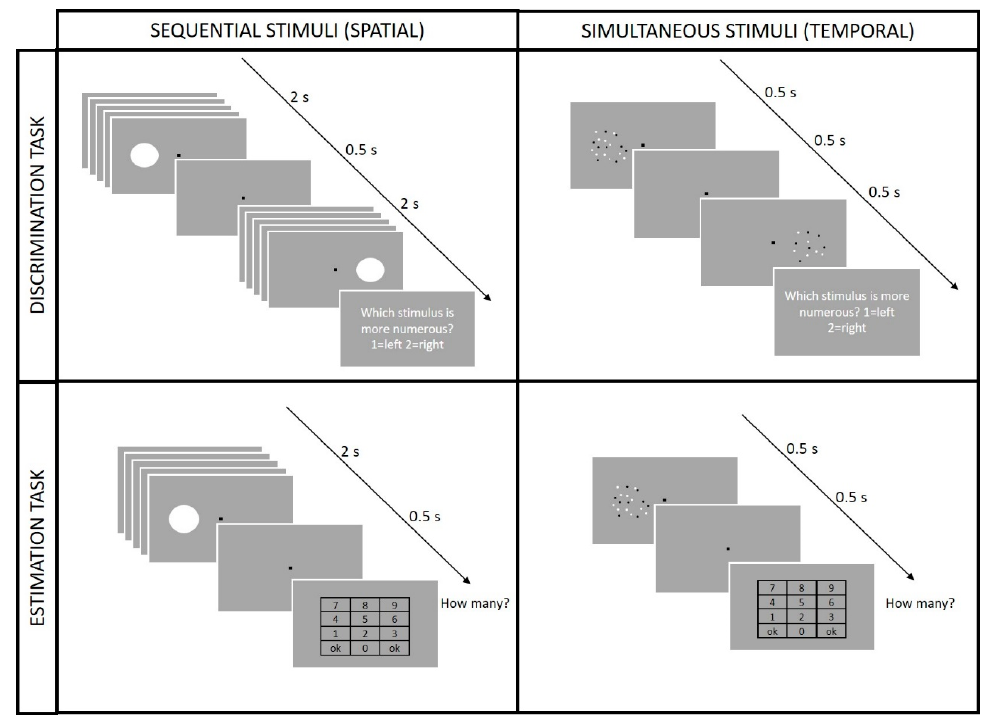
Figure 1. Schematic representation of the different experimental conditions. Participants performed either a discrimination task ( upper panels) or an estimation task ( lower panels) with the two tasks tested in separated sessions. Each task was carried out with two different classes of stimuli either presented sequentially (sequence of flashes shown in the right ) or simultaneously (arrays of dots, shown on the left ). Independently from the type of stimulus used, during the discrimination task ( top row), a test and a reference stimulus was presented sequentially and participants had to indicate which of the two stimuli was more numerous. In the estimation task ( bottom row), the participants saw only one stimulus that could appear either on the left or right of the screen and their task was to estimate the stimulus numerosity using a virtual numeric keypad.